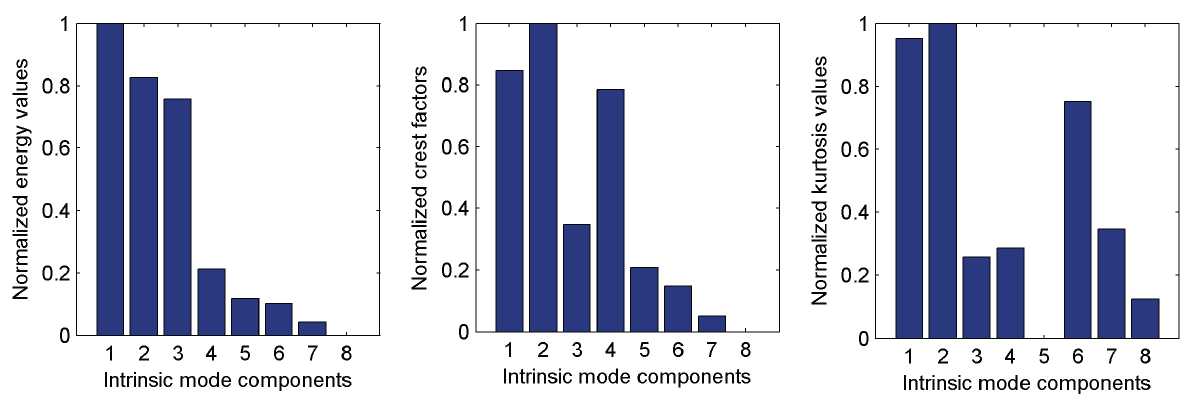
Figure 6. Normalized features of IMFs decomposed from current